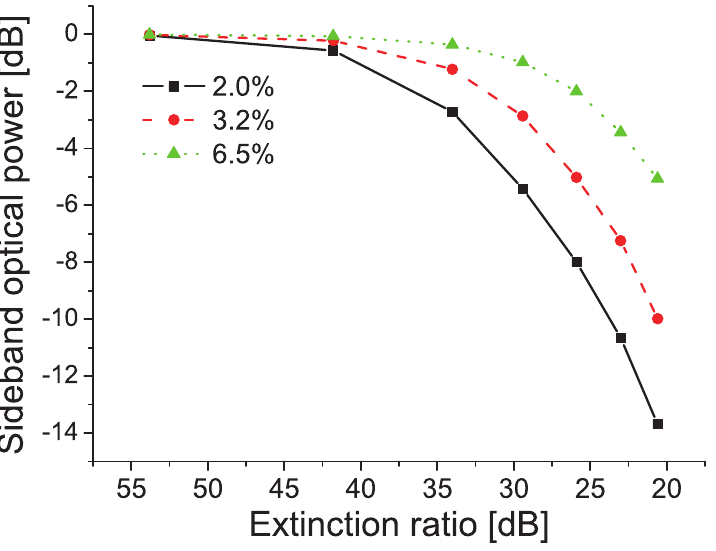
Figure 13. Sideband ratio to total optical output [12].